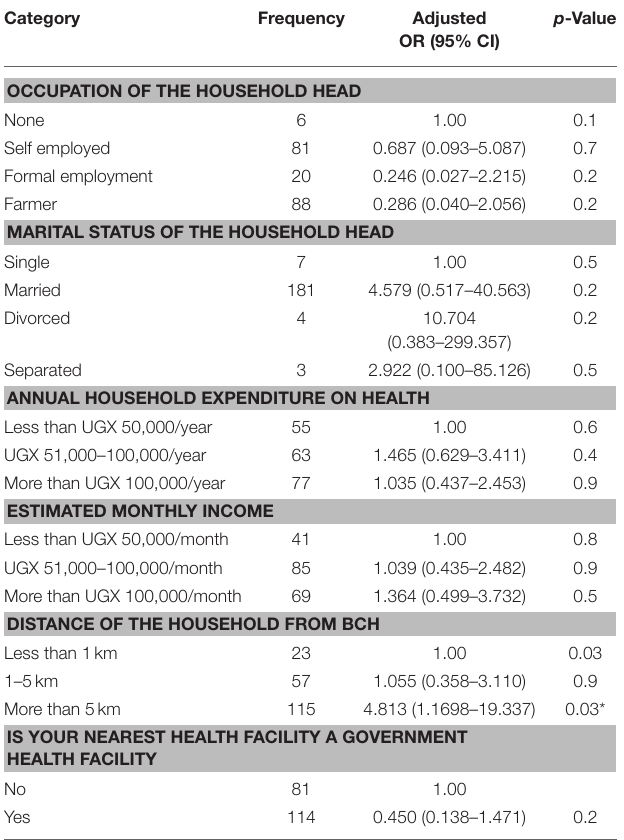
TABLE 12 | Results of the Multivariable analysis comparing users of BCH on insurance status.